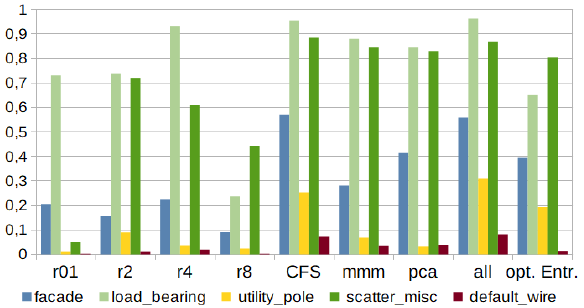
Figure 10. F1 - Ball-shaped neighbourhood, class wise performance of the Random Forest